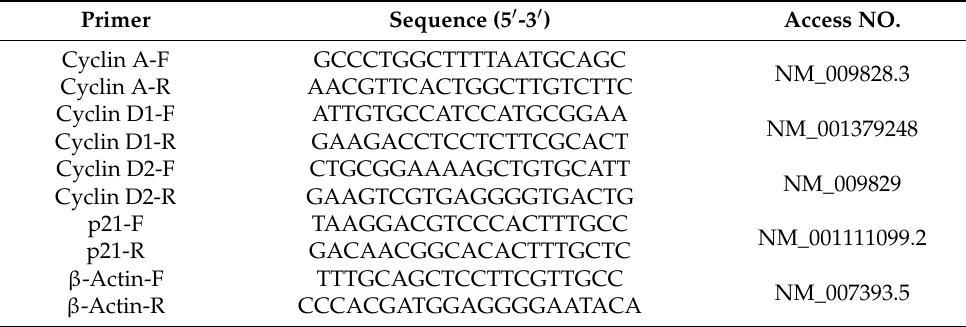
Table 1. Sequences of primer used for qRT-PCR. Primer Sequence (5 (cid:48) -3 (cid:48) ) Access